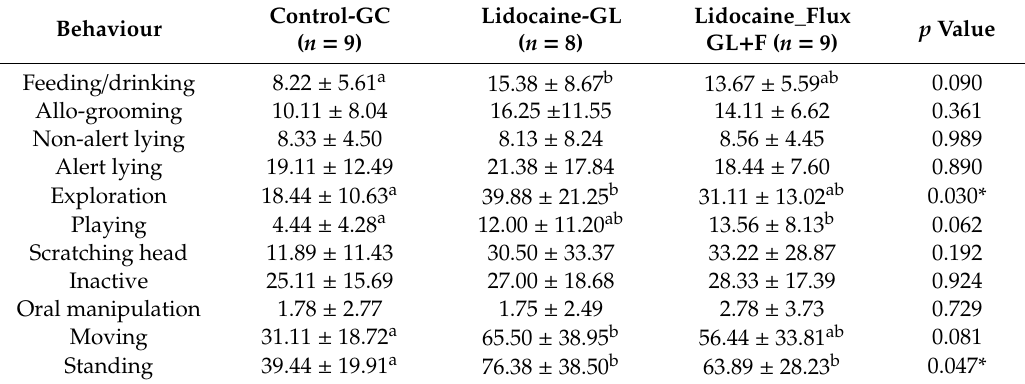
Table 3. Average number ( ± SD) of bouts of each state behaviour in the three treatments during the observation period, and relative significance levels of the di ff erences. Significance: * p < 0.05; letters (a and b) on the same line indicate statistically significant di ff erences (LSD test).